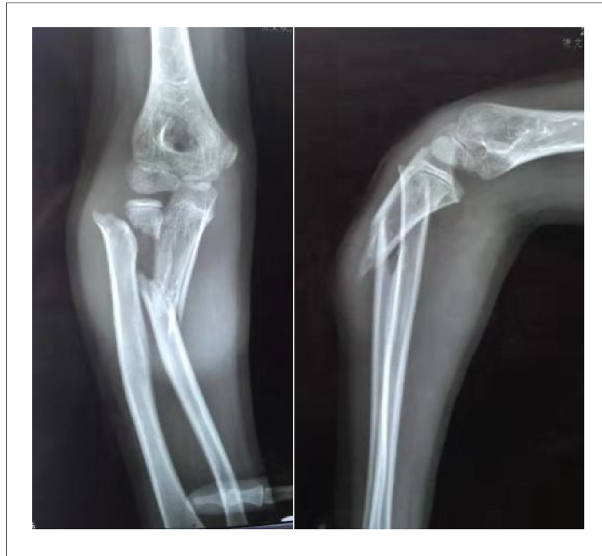
FIGURE 2 Flexion-varus type, an ulnar fracture with radial dorsal angulation plus a radial neck fracture with a radial dorsal displacement of the distal